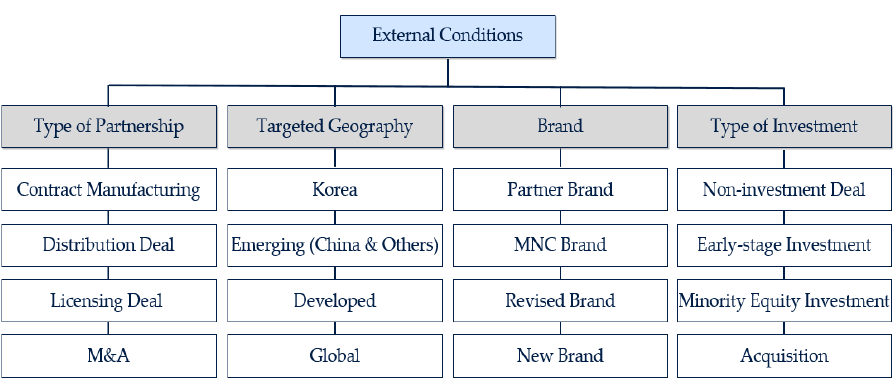
Table 1. Survey respondent demographics.